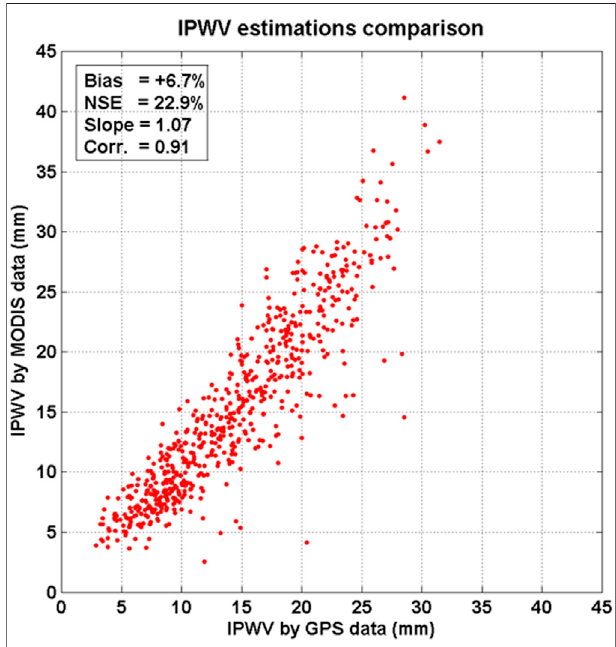
FIGURE 4 | Scatterplot of IPWV comparison between MODIS and GPS of one year of data (2015).